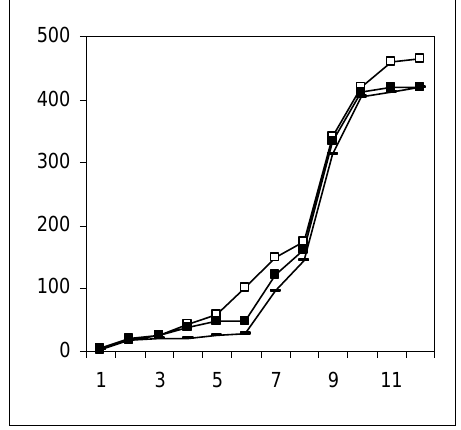
Figure 2. The effect of thyroxin 10 -30 , on lowland Rana temporaria, added from the spawn stage on. For further explanation, see legend to figure